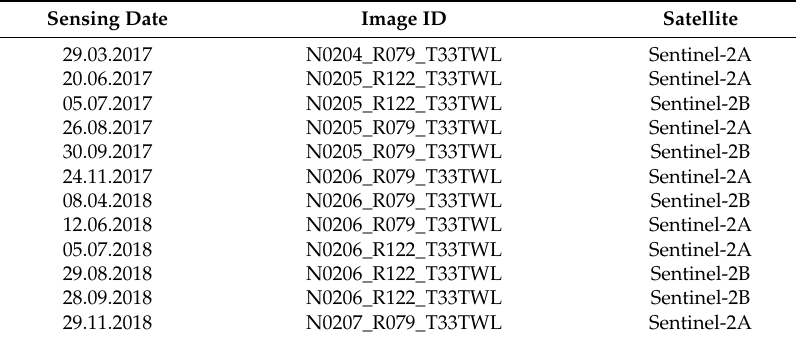
Table 1. Satellite images used in this study.